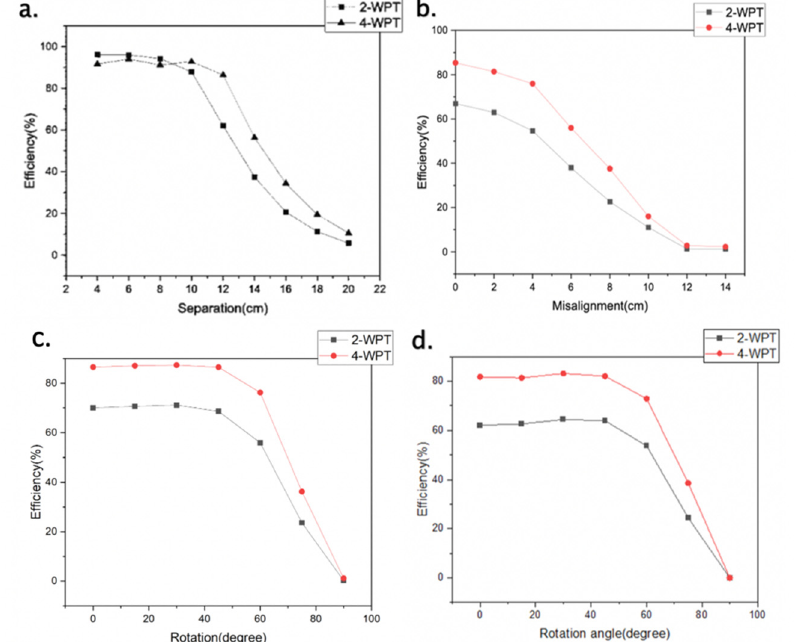
Figure 8. ( a ) Power efficiency against coil separation after the frequency was tuned. ( b ) Power efficiency at 12 cm of coil separation studied in axial misalignments. ( c ) Receiver rotating around the transmitter. ( d ) Receiver rotating around itself